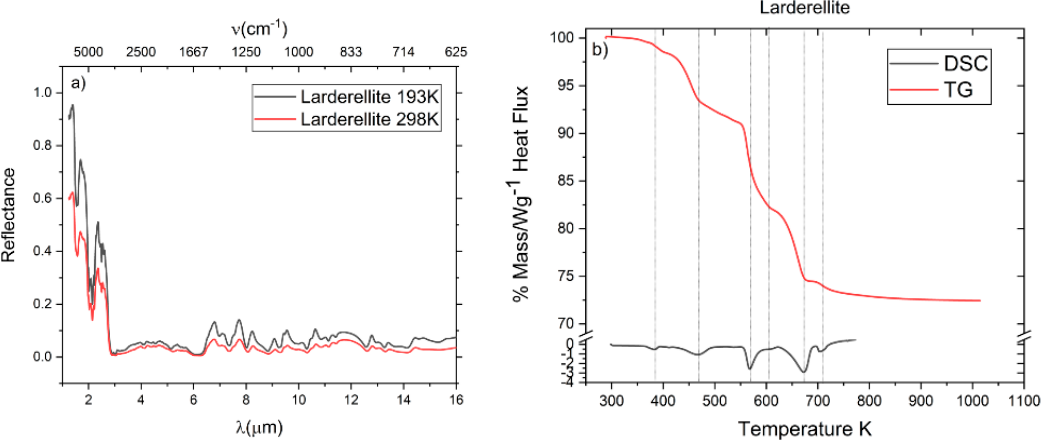
Figure 2. Reflectance spectra at room temperature and 193 K ( a ) and TG / DSC ( b ) analysis from room temperature to 773 and 1023 K of larderellite.